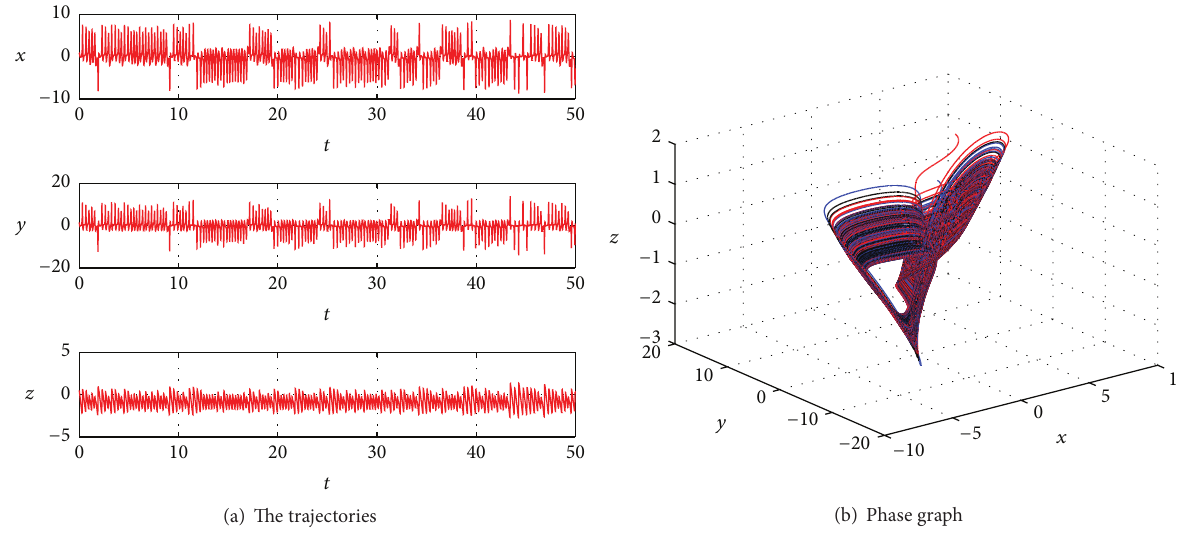
Figure 1: The trajectories and phase graphs of system (2) with 𝜏 = 0